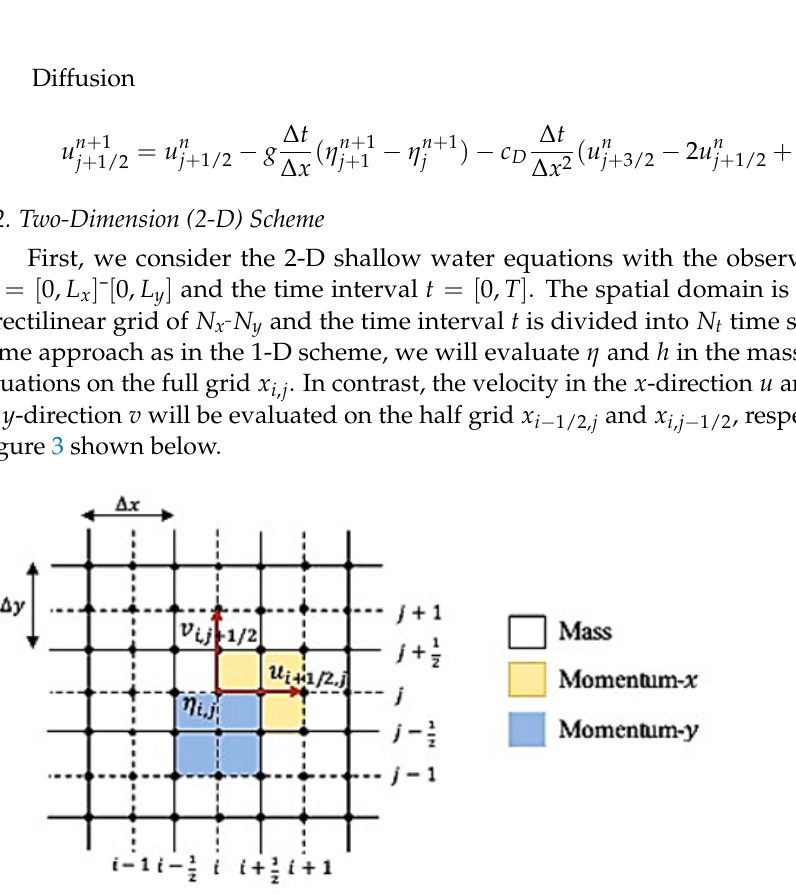
Figure 3. 2-D Staggered Grid Scheme (Arakawa C-Grid)